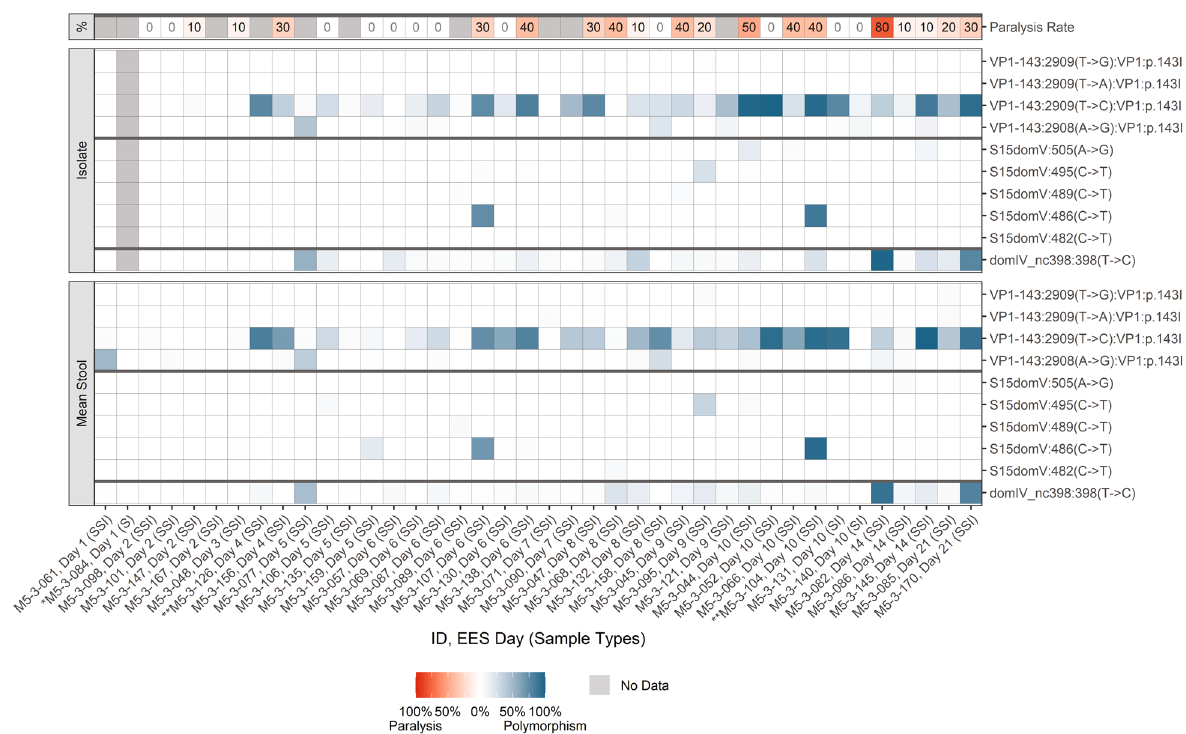
Fig. 5 nOPV2-c2. Frequency of polymorphisms in EES at known attenuation sites and mTgmNVT results. EES day shown with mTgmNVT result (red color gradient) and variant frequency (blue color gradient) averaged across two stool replicates (SS) and culture-ampli fi ed virus (I), if present. Amino acid associated with SNP indicated, if applicable. S = Stool replicate; I = Culture-ampli fi ed virus isolate (SSI = Two stool replicates and culture-ampli fi ed virus isolate; SI = Single stool replicate and isolate). White cells = polymorphism not detected. Gray cells = mTgmNVT result not available or no NGS data from stool (S)/ culture-ampli fi ed virus (I). *Day 1 = Insuf fi cient titer to test EES in mTgmNVT The NGS pipeline reports SNPs. Coding impact assumes changes are not in common genomes when multiple polymorphisms are observed in VP1-143. All SNPs reported have Q scores ≥